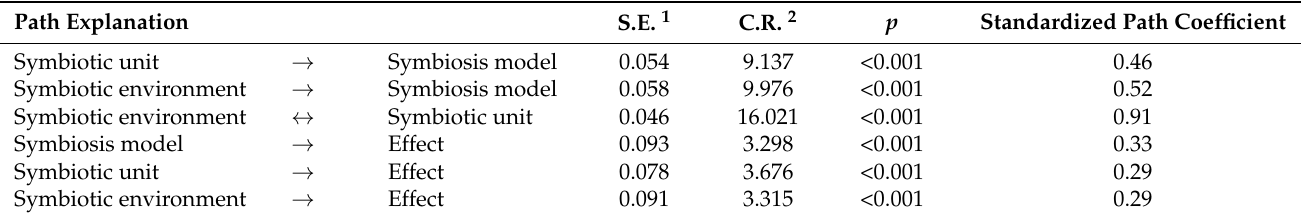
Table 8. Path explanation and